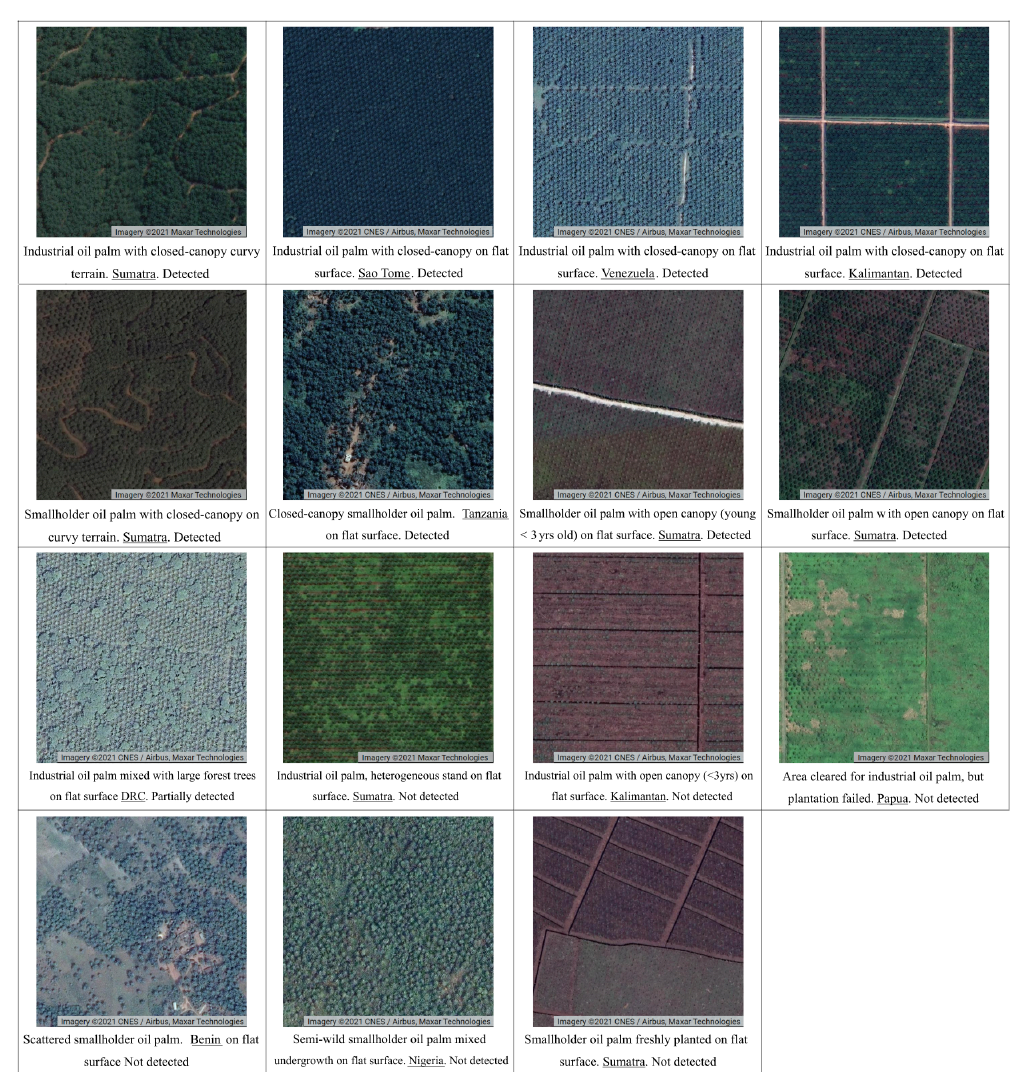
Figure A5. Examples of oil palm plantations around the world that have been detected or not detected by the model. One square is about 390m × 390m = 15ha. Source: see individual images and map data from © Google Earth